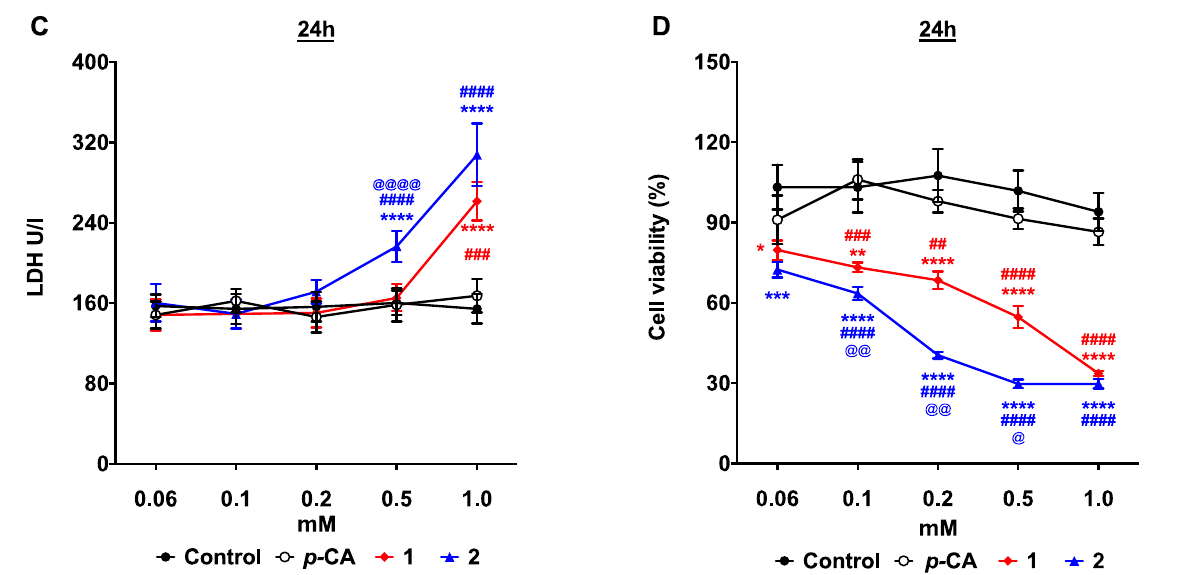
Figure 1. p -Coumaric acid esterification improves the cytotoxicity against the B16-F10 melanoma cells. Murine B16-F10 melanoma cells were incubated with different concentrations of p -coumaric acid ( p -CA, white circles), ethyl p -coumarate ( 1 , red lozenges), or n -butyl p -coumarate ( 2 , blue triangles) for 4 h or 24 h. Control cells were incubated with the equivalent concentrations of DMSO. ( A , C ): LDH quantification in culture supernatants; ( B , D ): frequency of viable cells. * p < 0.05, ** p < 0.01, *** p < 0.001, **** p < 0.0001 compounds 1 or 2 vs. Control; ## p < 0.01, ### p < 0.001, #### p < 0.0001 compounds 1 or 2 vs. p -CA; @ p < 0.05, @@ p < 0.005, @@@@ p < 0.0001 compound 2 vs. 1